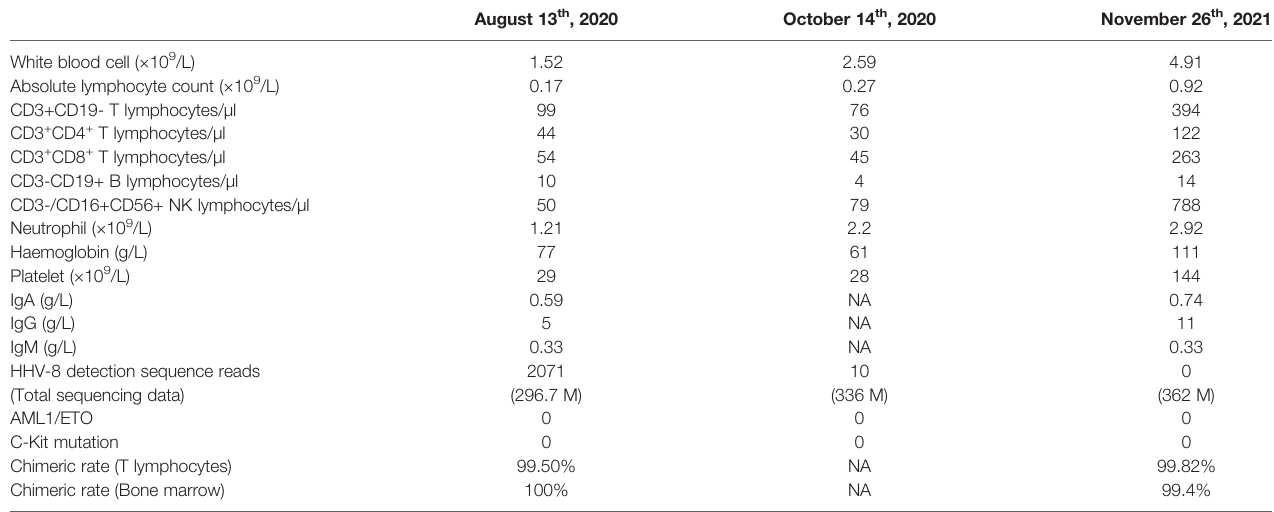
TABLE 1 | Clinical features and HHV-8 virologic study of the patient after allogeneic haematopoietic stem cell